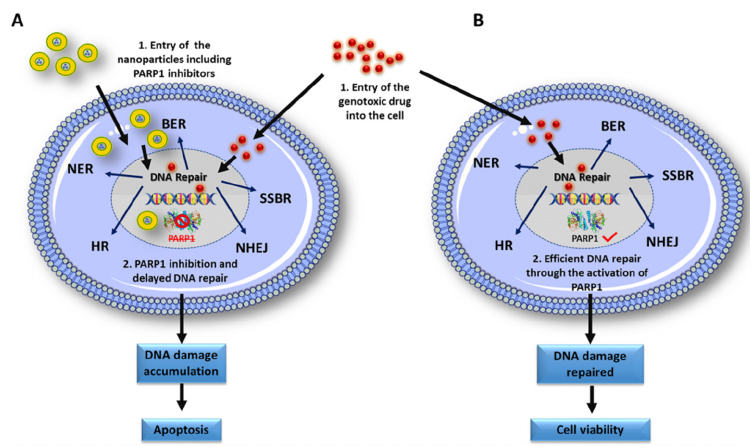
Figure 2. Nanoformulations to tackle drug resistance induced by PARP1. PARP1 modulates DNA damage repair by single-strand (SSBR, BER and NER) and double-strand (HR and NHEJ) repair DNA damage repair by single-chain (SSBR, BER and NER) and double-chain (HR and NHEJ) repair pathways. Nanoformulations containing PARP inhibitors have been designed to inhibit these mechanisms in different types of cancer. Nanoliposomes ( A ) and solid NPs ( B ) containing tala- pathways. PARP inhibitors are used to avoid drug resistance by limiting PARP1 functions in the zoparib to overcome drug resistance in BRCA-negative and triple negative breast cancer; ( C ) NPs different DNA repair pathways in which this protein is involved and therefore nanoformulations loaded with Olaparib and GEM directed to BRCA2-negative cells overexpressing EGFR to over- containing PARP inhibitors have been designed for different types of cancer. ( A ) The simultaneous come drug resistance in pancreatic cancer; ( D ) Arsenite-loaded NPs used in hepatocellular cancer to overcome DOX resistance; ( E ) NPs containing olaparib to sensitize p53 -deficient prostate cancer entry of nanoparticles containing PARP1 inhibitors together with the genotoxic drug causes the cells to radiotherapy; ( F ) Olaparib and cisplatin-loaded NPs to overcome cisplatin resistance. inactivation of PARP1, necessary for the efficient repair of DNA damage through all the routes in which it is involved. This causes that the damages produced by the genotoxic agent in the DNA are not repairable, inducing cellular apoptosis.; ( B ) Entry of the genotoxic agent into the cell produces easily repairable DNA damage through DNA repair pathways where PARP1 acts as an important effector, leading to cell survival. Abbreviations: homologous recombination